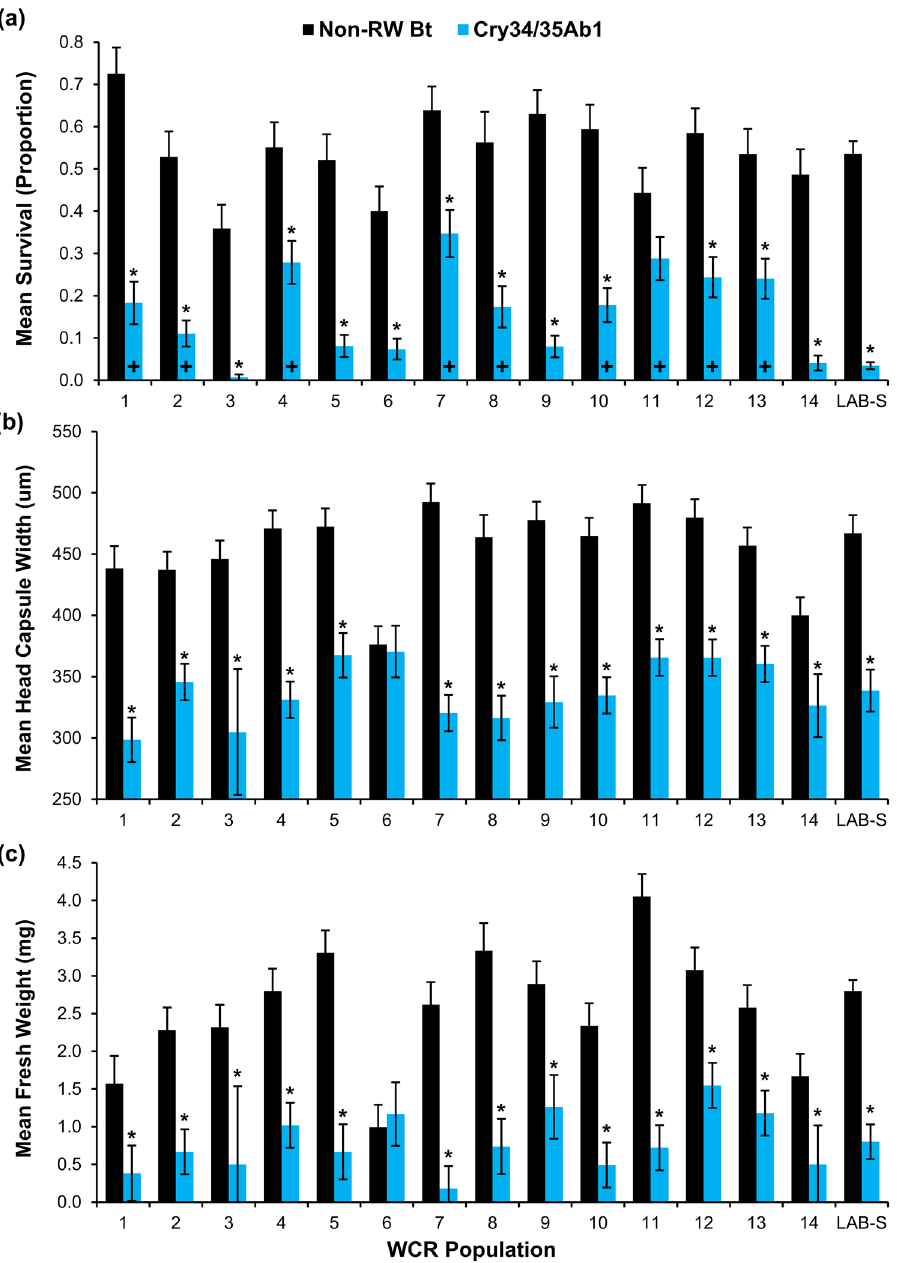
Figure 2. Larval survival and development of western corn rootworm populations bioassayed on non- rootworm Bt and Cry34/35Ab1 maize in 2019. ( a ) Mean proportional survival (± SE), ( b ) mean head capsule width (± SE), and ( c ) mean fresh weight (± SE). Asterisks above Cry34/35Ab1 bars indicate significantly lower survival or development compared to the non-rootworm Bt hybrid within a population (Tukey’s multiplicity adjustment, p < 0.05). A ‘+’ within Cry34/35Ab1 bars indicates significantly greater survival or development on Cry34/35Ab1 maize relative to the susceptible laboratory control (Dunnett’s test, p <